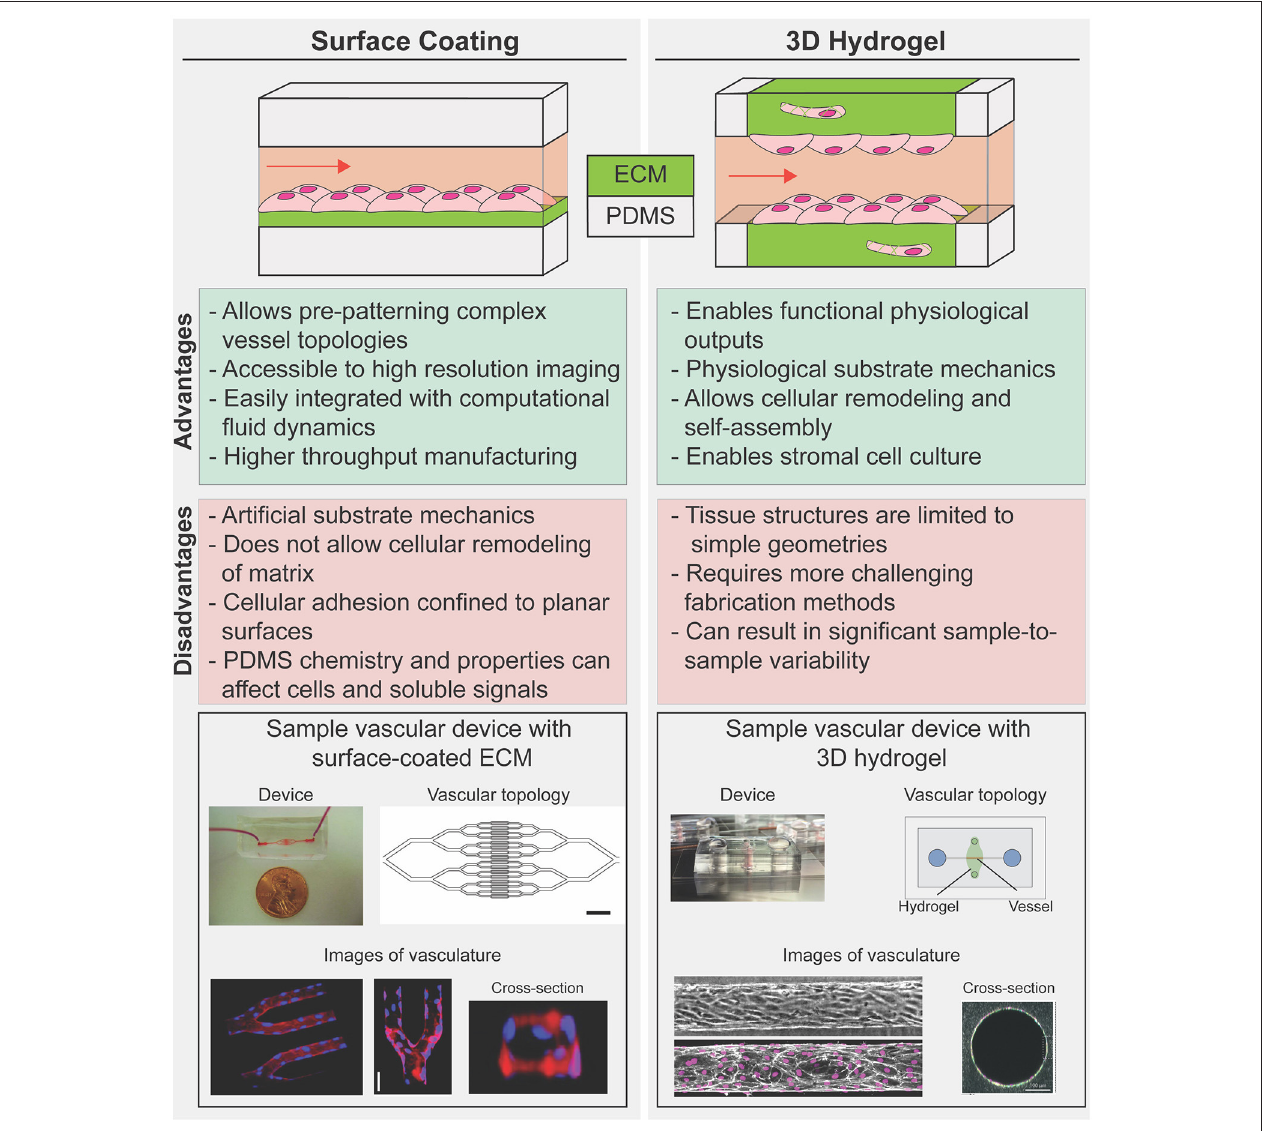
FIGURE 2 | Strategies to reconstruct cells-ECM microenvironments in microfluidic disease models. 2D coated surfaces (left) and 3D hydrogels (right) each provide unique experimental advantages and limitations. Surface coated PDMS membrane is commonly used as substrate in platforms that have been used to investigate the effect of cyclic stress on cellular function or those that require complex geometry (bottom, left). 3D hydrogel systems are often limited to linear geometries but provide an optimal mechanical cellular microenvironment to study how spatial and mechanical cues in 3D influence vascular dynamics in diseases while allowing for cellular co-culture and hydrogel remodeling (bottom, right). [bottom, left: Images republished with permission of American Society for Clinical Investigation from Tsai et al. (2011); permissions conveyed through Copyright Clearance Center Inc. Bottom, right; Top: reproduced from Polacheck et al. (2019); Bottom: Reproduced from Wang et al. (2020) with permission from the Royal Society of